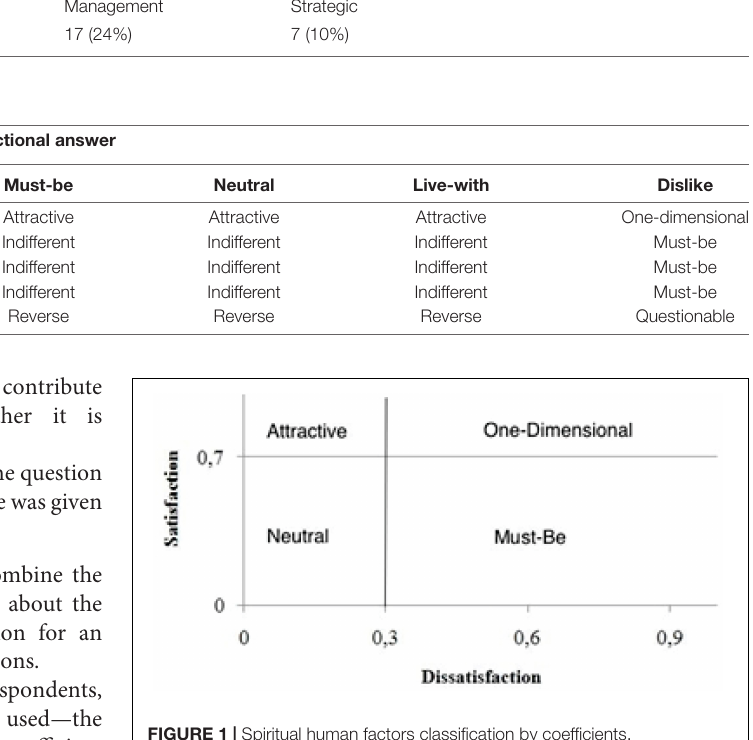
FIGURE 1 | Spiritual human factors classification by